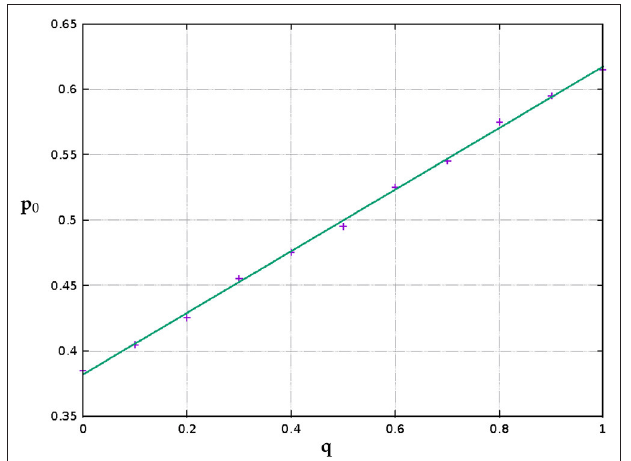
FIGURE 3 | A plot showing how the probability at which there exist an equal number of black and white clusters i.e., p 0 varies with diagonal connection probability q . The error bounds lie within the symbol size.